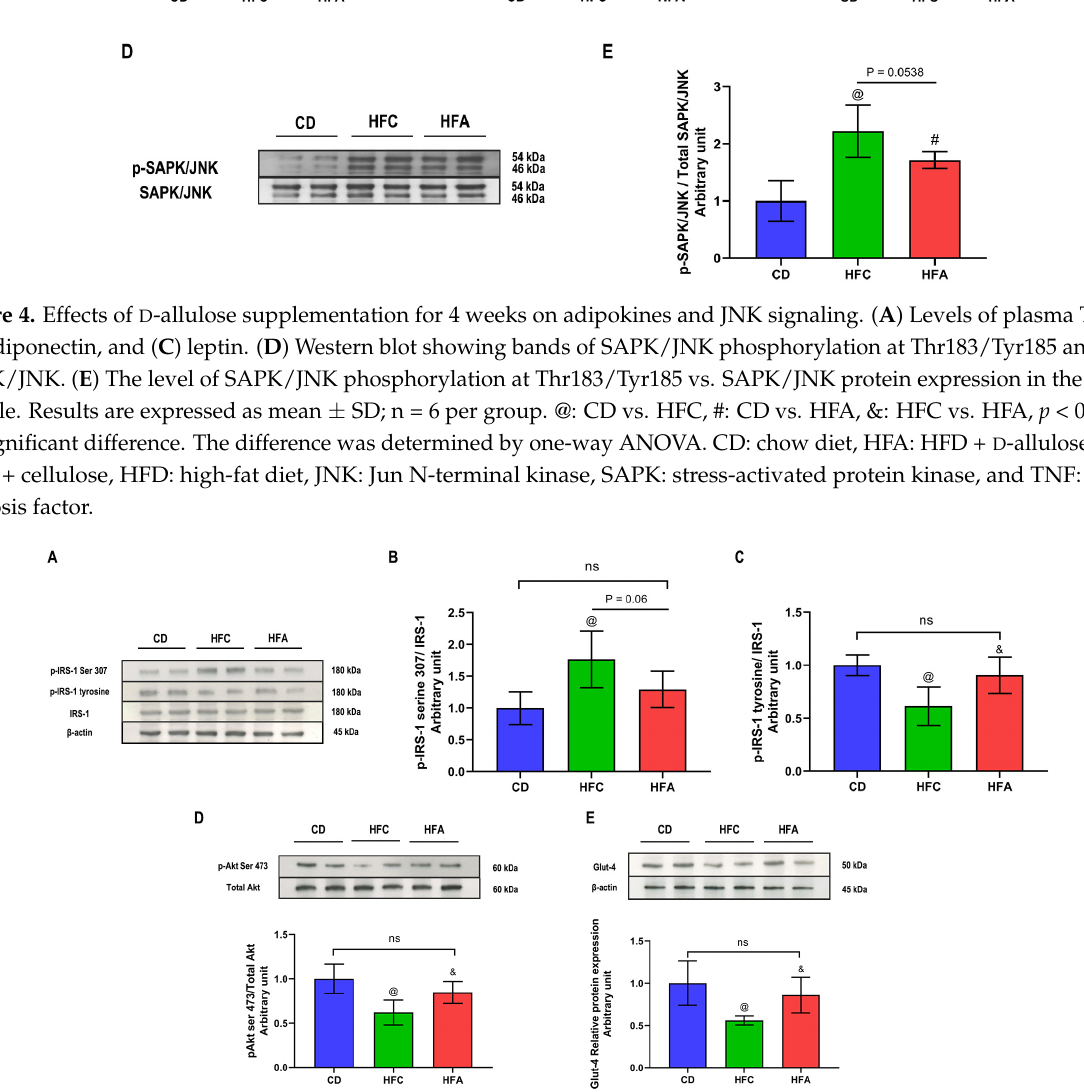
Figure 5 . Effects of D -allulose on insulin signaling and Glut-4 expression in the soleus muscle. ( A ) Phosphorylation of IRS-1 at serine 307 and tyrosine vs. protein expression of IRS-1. ( B ) The level of insulin-stimulated phosphorylation of IRS-1 at serine 307 vs. IRS-1 protein expression. ( C ) The ratio of insulin-stimulated phosphorylation of IRS-1 at the tyrosine residue vs. IRS-1 protein expression. ( D ) The level of insulin-stimulated phosphorylation of Akt at serine 473 vs. total Akt, ( E ) Glut-4 protein expression. Results are expressed as mean ± SD; n = 6 per group, @: CD vs. HFC, &: HFC vs. HFA, p < 0.05; and ns, no significant difference. The difference was determined using one-way ANOVA. All the western blots used for the quantitative analysis are presented in Supplementary Figure S1. Akt: Protein kinase B, CD: chow diet, Glut-4: glucose transporter 4, HFA: HFD + D -allulose, HFC: HFD + cellulose, HFD: high-fat diet, and IRS-1: insulin receptor